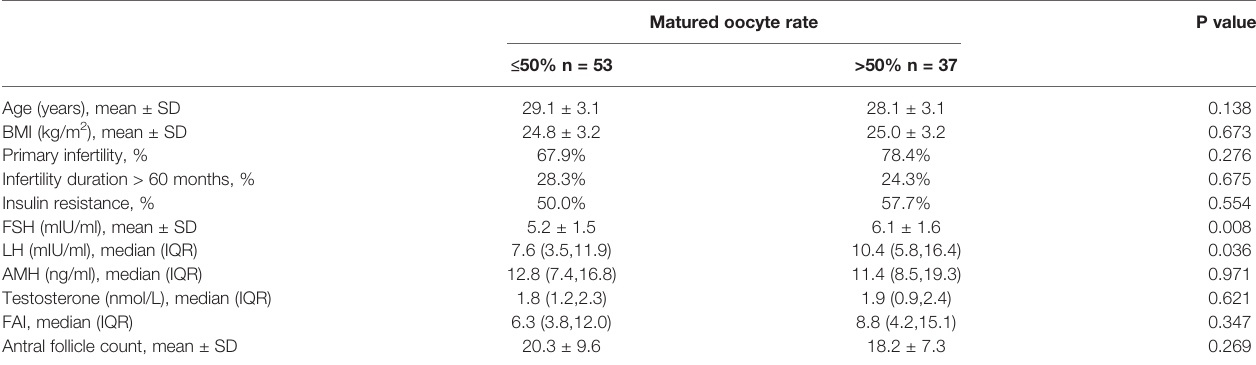
TABLE 4 | Factors in fl uencing oocyte maturation rate during IVM-surgery.